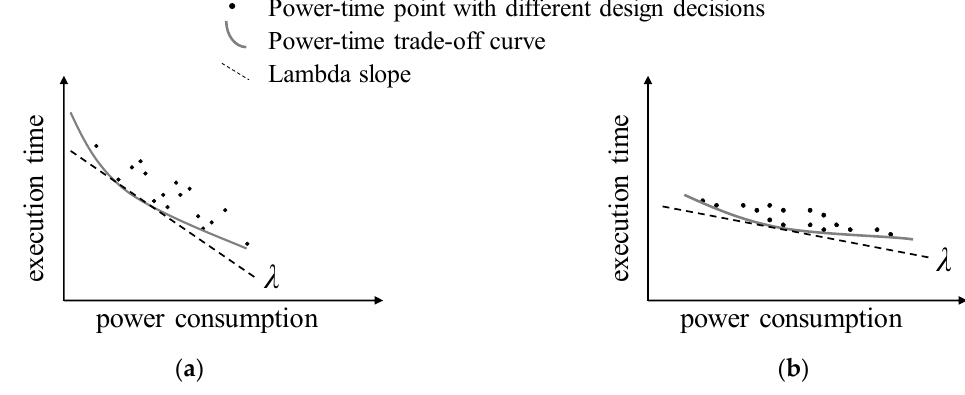
Figure 2. Power-Time curve ( a ) when a power constraint is low and ( b ) when a power constraint is high .